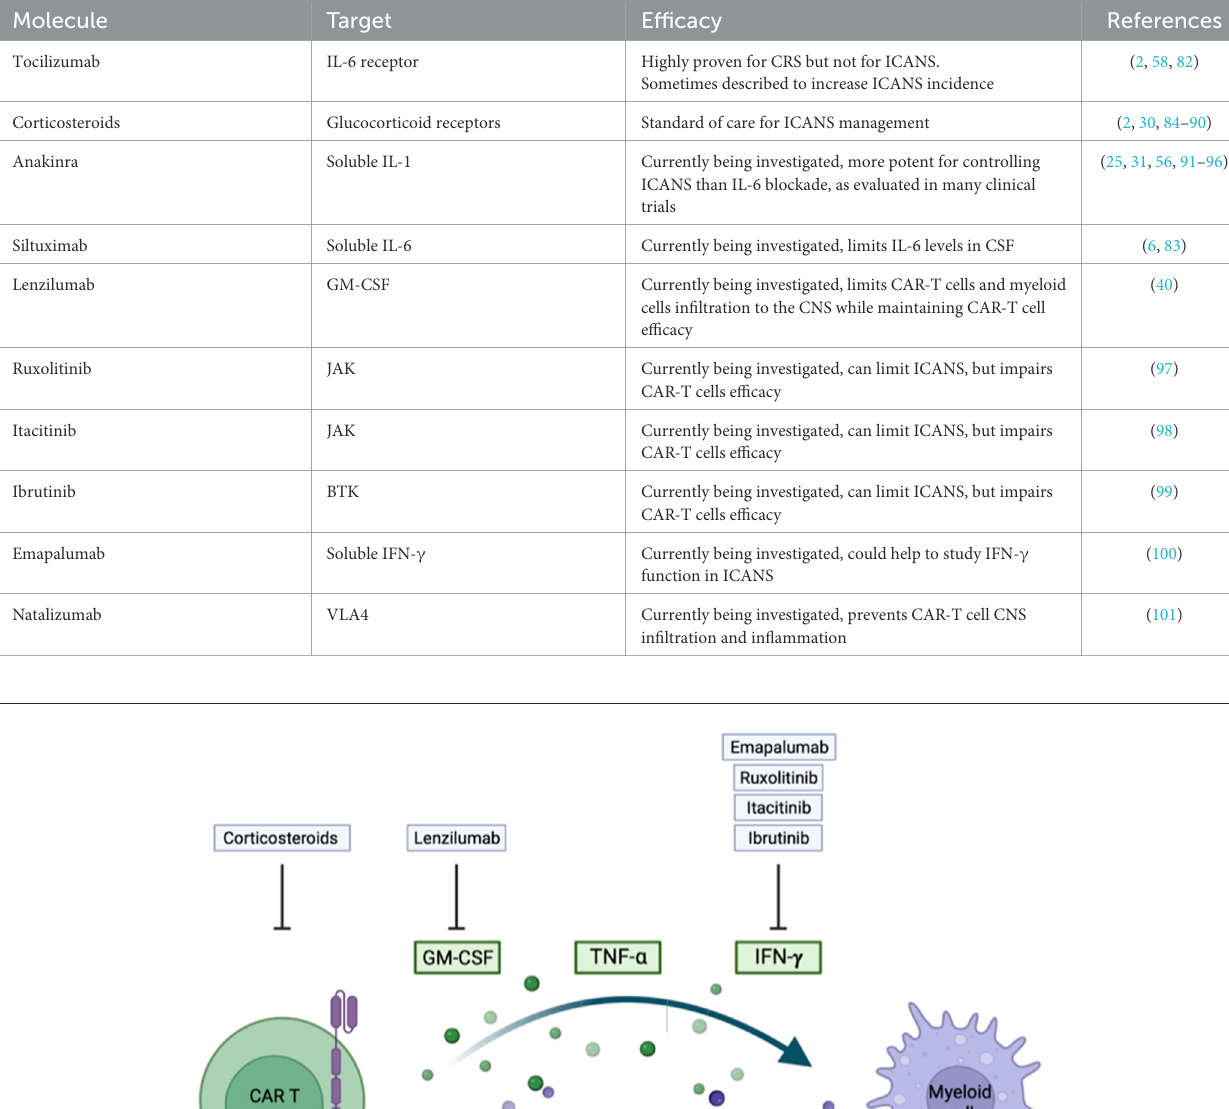
TABLE 1 Strategies for ICANS management.